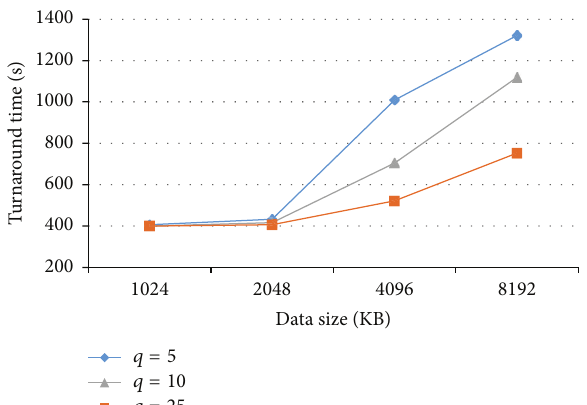
Figure 8: Energy consumption and quantum parameter.